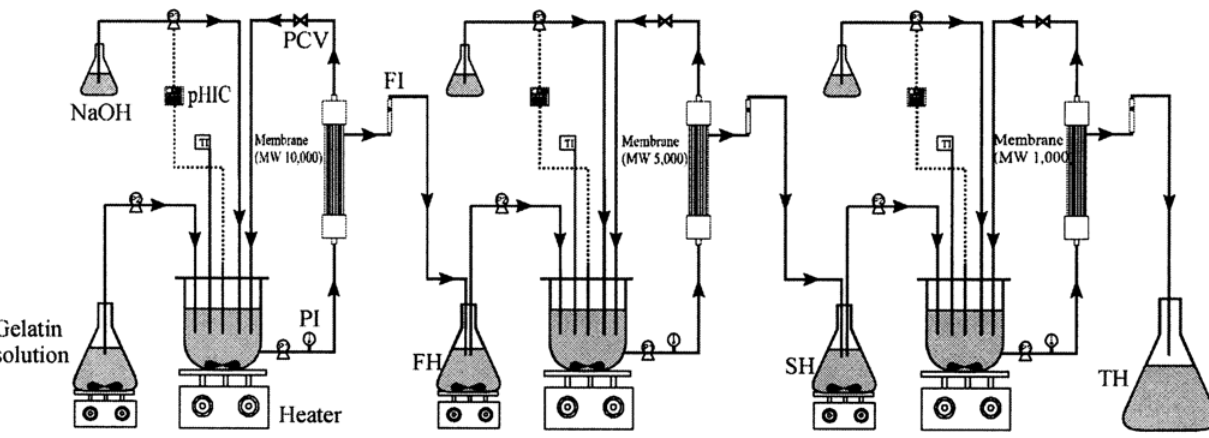
Figure 4. Three-step recycling membrane bioreactor for the production and separation of enzymic hydrolyzates of Alaska Pollack skin gelatin. TI, temperature indicator; PI, pressure indicator; FI, flow indicator; P1, recycling pump; P2, feed pump; P3, NaOH pump; PCV, pressure control valve; pHIC, pH indicator controller; FH, first hydrolysates; SH, second hydrolysates; TH, third hydrolyzate (Adapted from Byun and Kim